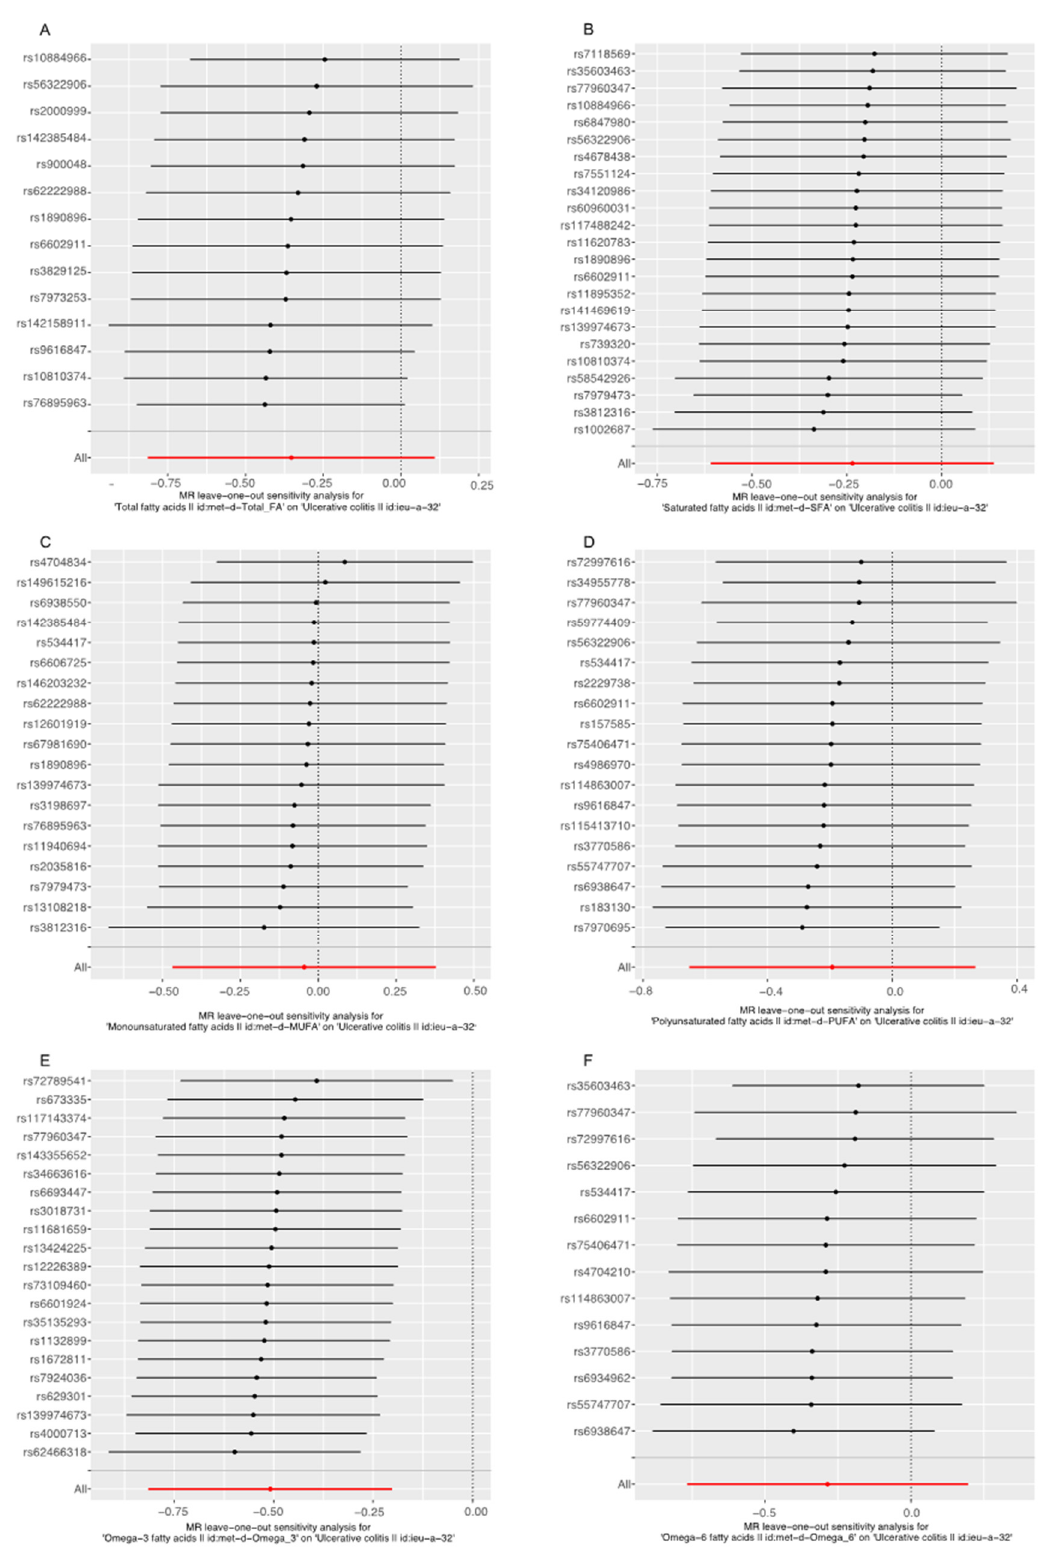
Figure 5. Leave-one-out analysis for the effect of fatty acids (FAs) and Ulcerative colitis (UC). ( A ) Analysis of Total FA and UC; ( B ) Analysis of saturated FA and UC; ( C ) Analysis of monounsatu- rated FA and UC; ( D ) Analysis of polyunsaturated FA and UC; ( E ) Analysis of Omega-3 FA and UC; ( F ) Analysis of Omega-6 FA and UC.